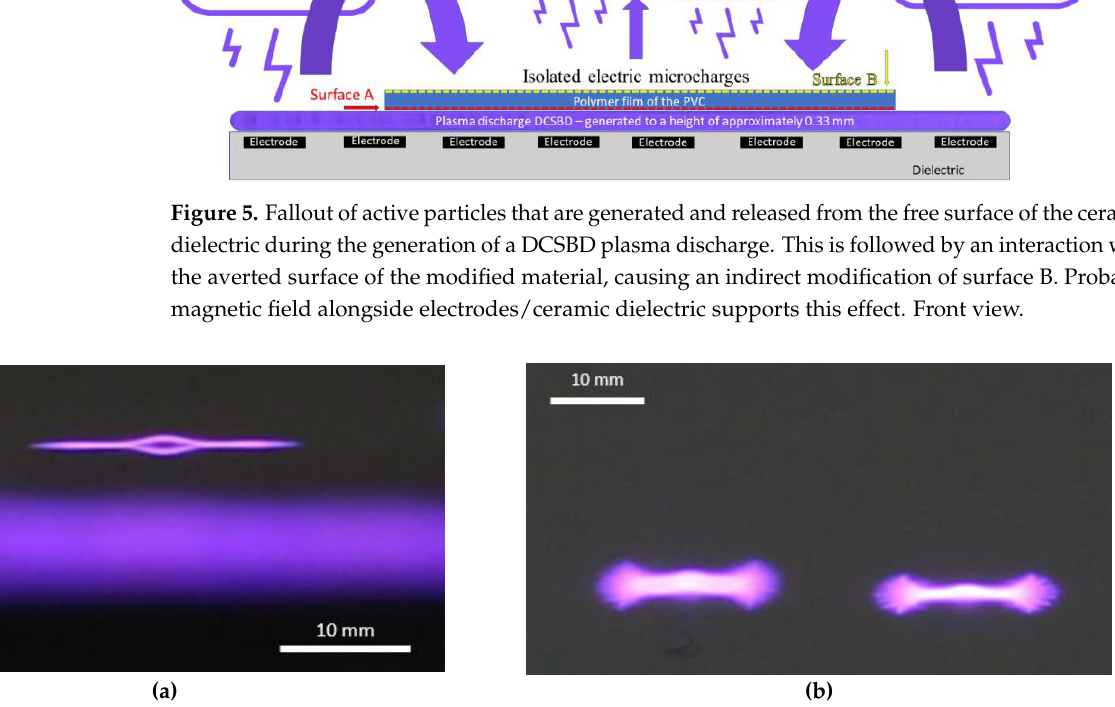
Figure 6 . Insulated electric micro discharge generated on the ceramic dielectric of a KPR plasma reactor 20 (front view) and the shape of the electric micro discharges. (view at 15° and 45° angle), ( a ) front view at 15° angle, ( b ) front view at 45° angle.